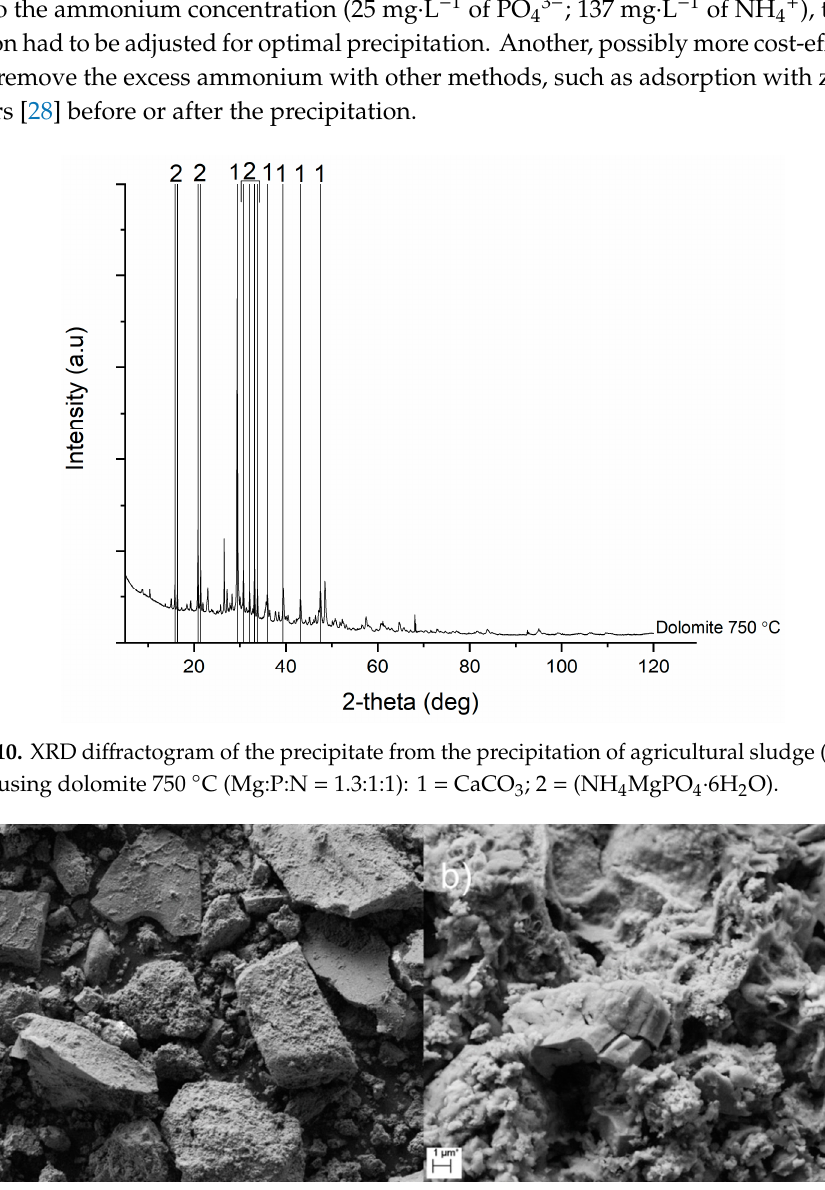
Figure 11 . SEM images of the precipitate from the precipitation of agricultural sludge with dolomite 750 °C (Mg:P:N = 1.3:1:1). Scale bars: ( a ) 10 µm; and ( b ) 1 µm.